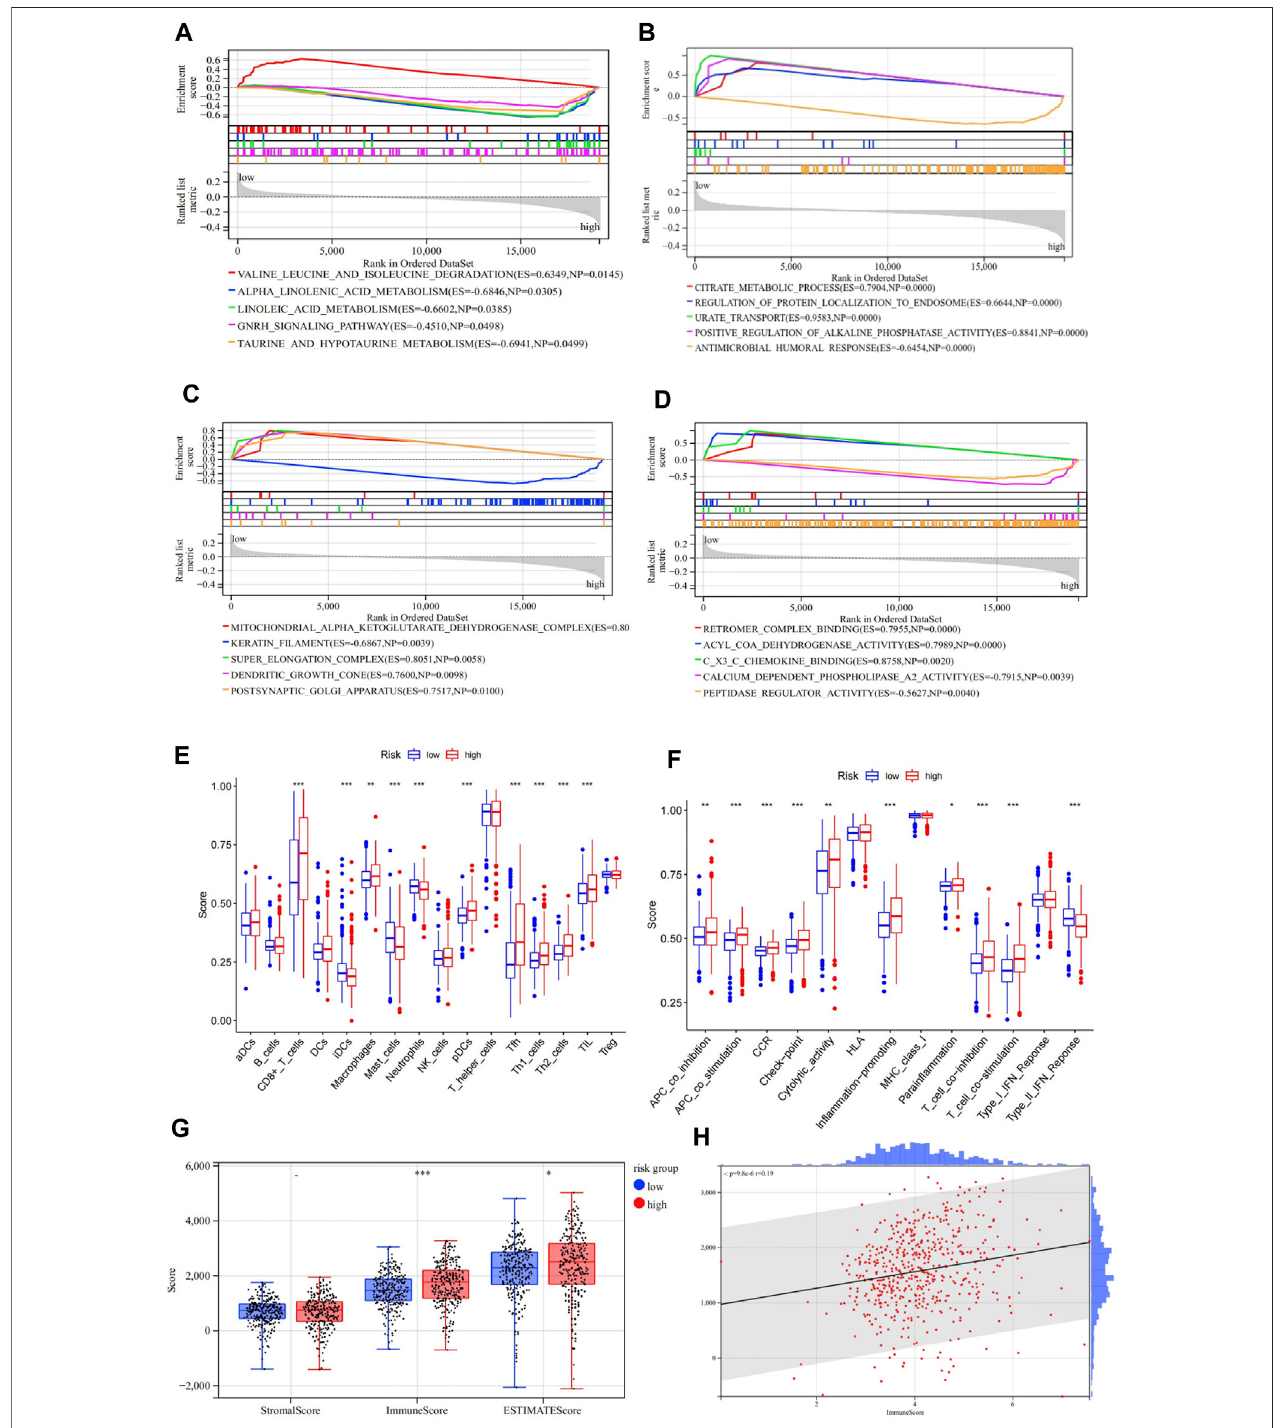
FIGURE5| GeneSetEnrichmentAnalysis(GSEA)ofthehigh-and low-riskgroupsinTCGA. (A) Enriched KEGGpathways betweenthehigh-andlow-riskgroups. (B – D) Enriched GOBP,GOCC,andGOMFtermsbetweenthehigh-andlow-riskgroups. (E,F) Enrichmentresultsoftheimmunecellandimmunefunctionscoresofthe high- and low-risk groups. (G,H) Results of the stromal/immune/ESTIMATES scores of the high- and low-risk groups.